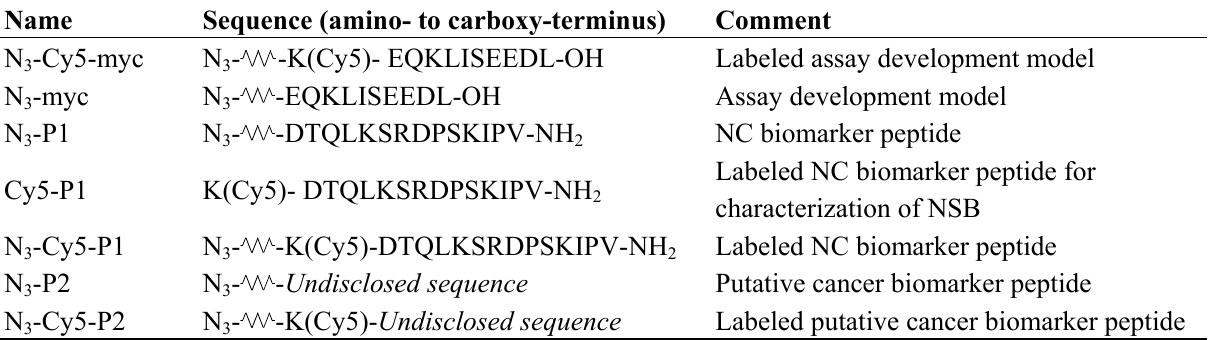
Table 1. Description of peptides used in this study and their chemical modifications.